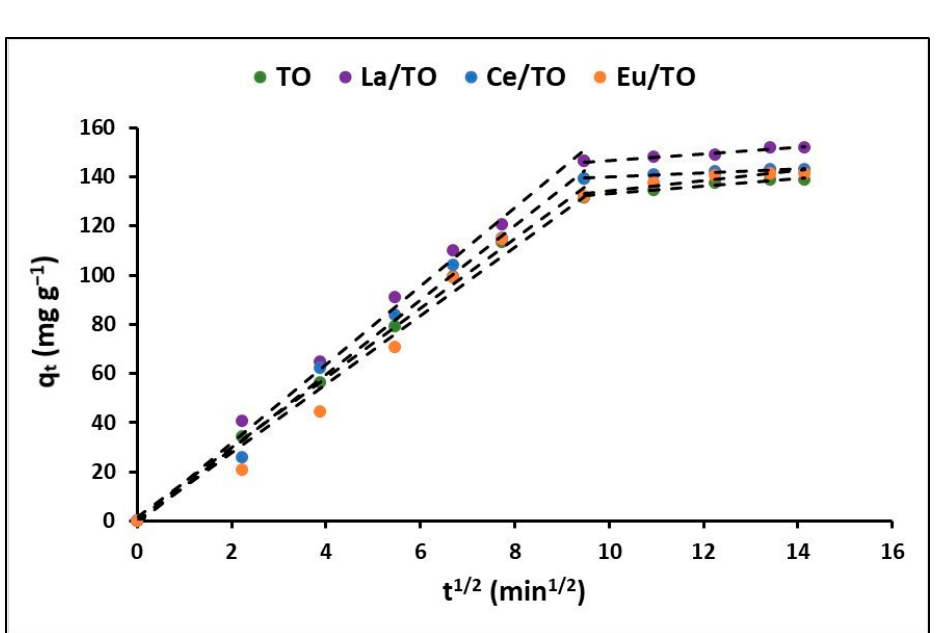
Figure 10. Intraparticle diffusion plots for cyanide removal by nanoparticles.